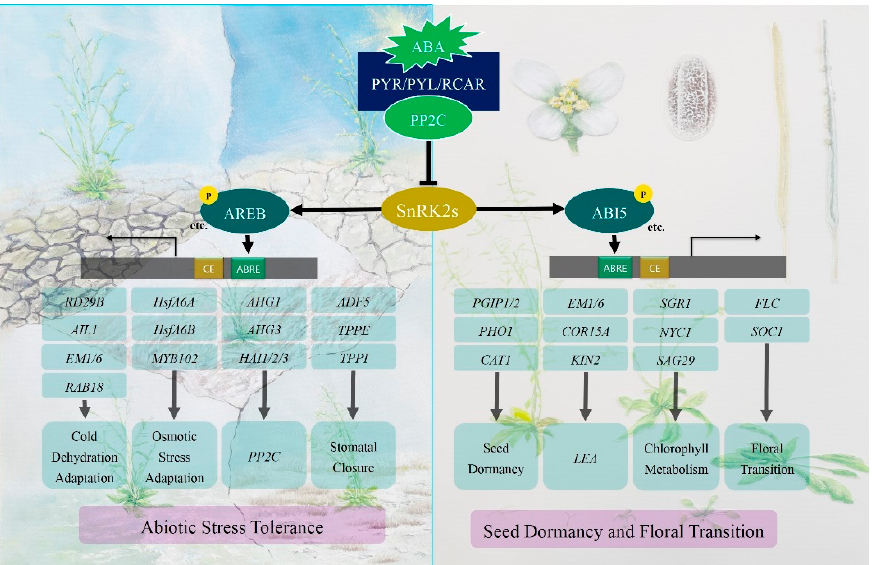
Figure 1. Schematic diagram of ABA-mediated transcriptional regulation of plant. The PYL-PP2C- SnRK2s-TFs complex regulate the ABA-mediated ABRE-dependent gene expression. Two distinct family TFs (ABI5 and AREB/ABF) regulate the ABA-mediated gene expression in response to abiotic stress and development in Arabidopsis by interacting with cis-elements in the upstream promoter regions of target genes. See text for details.